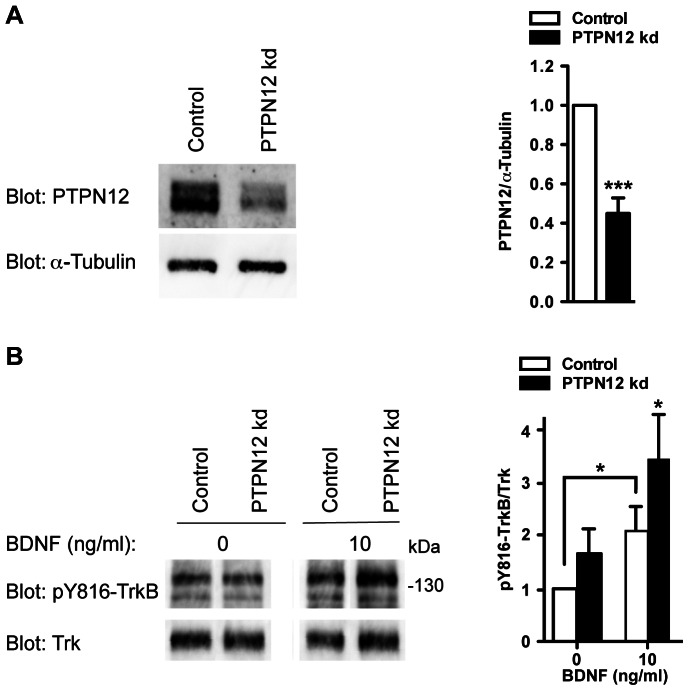
PTPTN12 knockdown in primary mouse hippocampal neurons enhances tyrosine phosphorylation of TrkB.A) Western blot analysis of PTPN12 expression in mouse hippocampal neurons expressing a pLKO-shRNA targeting PTPN12 (PTPN12 kd) or a non-silencing control. α-Tubulin is used as reference. Densitometric quantification of PTPN12 expression is shown as mean and S.E.M. of five independent experiments, and values are normalized to the level of the non-silencing control. B) Western blot analysis of pY816-TrkB and Trk levels in mouse hippocampal neurons expressing a pLKO-shRNA targeting PTPN12 (PTPN12 kd) or a non-silencing control. The neurons were cultured for 5 days and then stimulated for 5 min with 0 or 10 ng/ml BDNF. Densitometric quantification of pY816-TrkB compared to total Trk levels are shown as mean and S.E.M. of five independent experiments, and values are normalized to the level of the control in the absence of BDNF. Statistical analyses were performed using Student’s paired t-test comparing control and Ptpn12 kd, except when otherwise specified (*: p≤0.05; ***: p≤0.005).